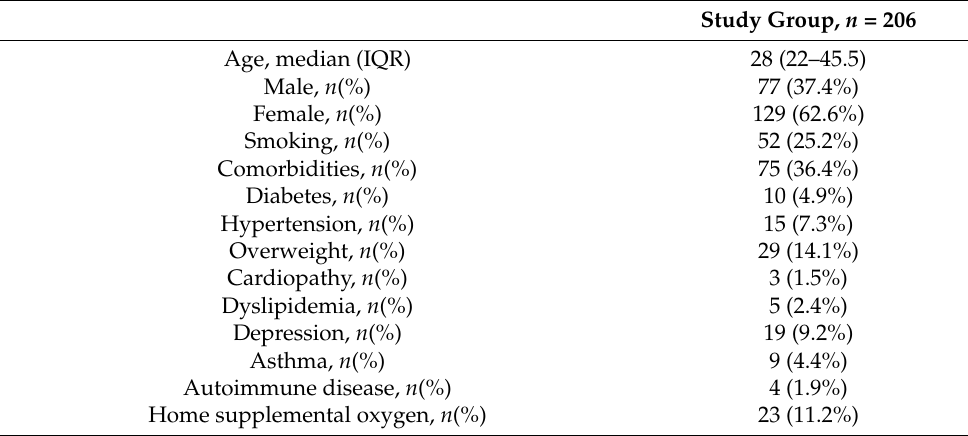
Table 1. General characteristics of ambulatory patients recovered from